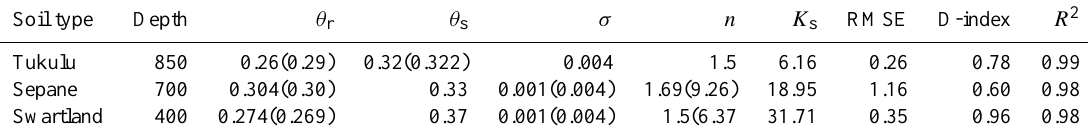
Table 5. Optimised parameters of van Genuchten–Mualem model for equivalent homogenous soil profiles. Soil